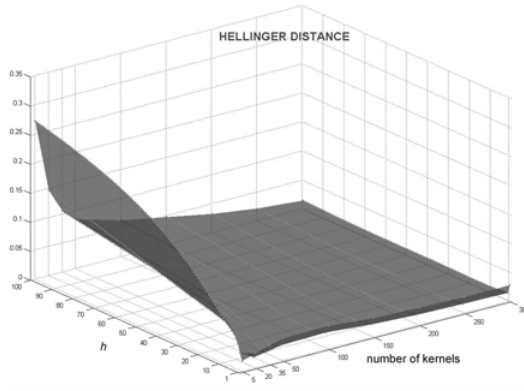
Fig. 4. Mean distance between the true PDF and its vector quantization based Parzen estimation with varying width scaling factor h and number K of kernels.